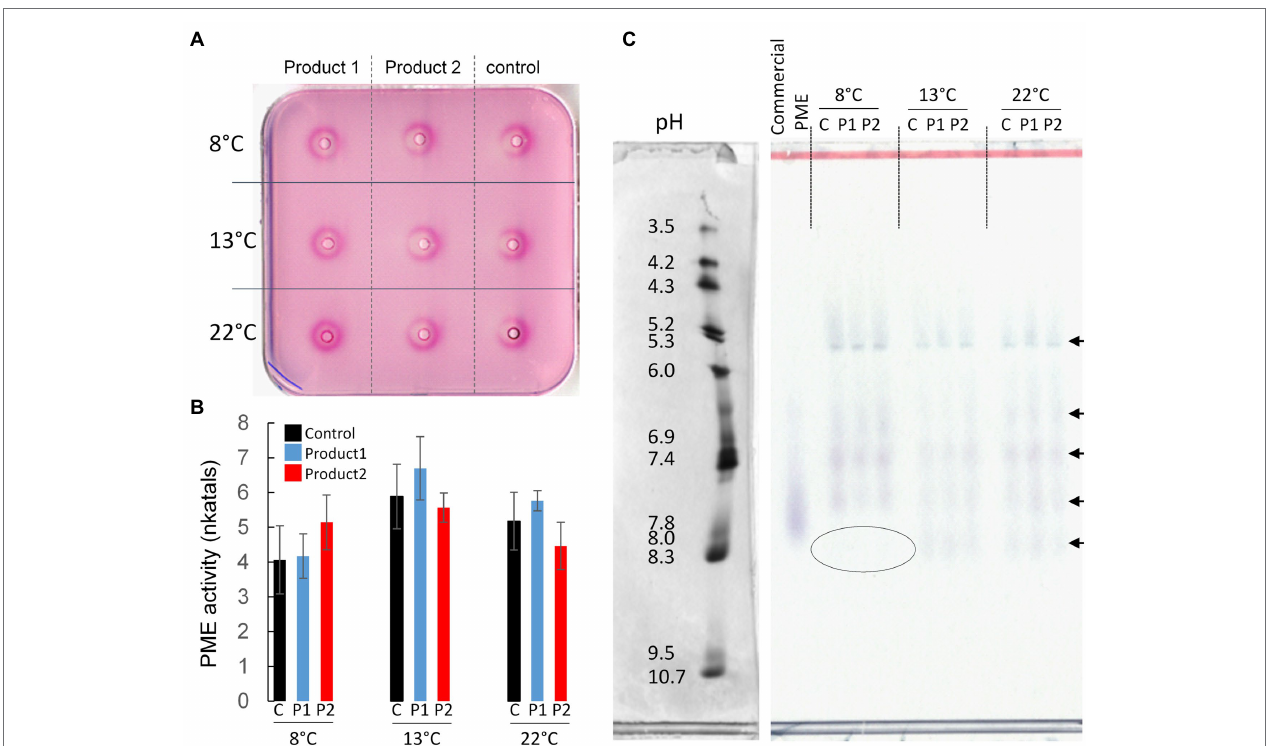
FIGURE 6 | Determination of total PME activity and separation of the different isoforms. (A,B) Gel diffusion assay, and quantification of total PME activity expressed as nkatals in 20 μ g of proteins extracted from pollen tubes cultivated for 4*D at 8, 13, and 22 ° C in the control condition (black) or in a medium containing 2 μ g.ml − 1 of P1 (blue) or P2 (red). (C) Zymogram after IEF showing the different PME isoform activities. A citrus commercial PME was used as positive control. A volume of protein corresponding to 0.05 units of PME activity (U) was loaded in each well. C, control. Arrows indicate the main PME isoforms. The left in (C) corresponds to the pI markers of the native gels stained with coomassie